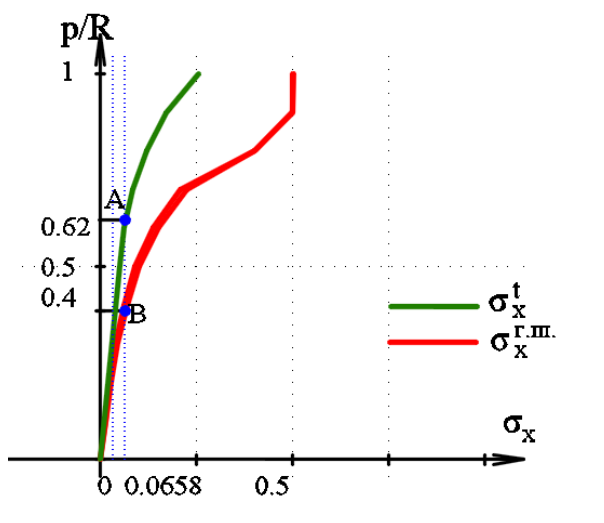
Fig. 5. Tensile stresses in a horizontal row of masonry and horizontal joint